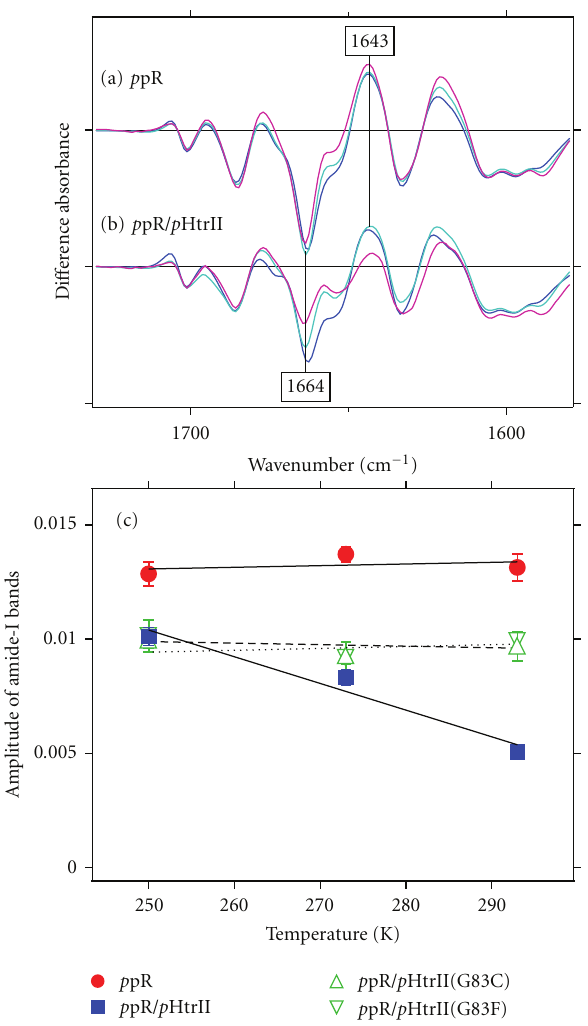
Figure 7: (The upper panel) p pR minus p pR infrared di ff erence M spectra without (a) and with (b) p HtrII in the 1730–1520 cm − 1 region. Spectra are measured at 250K (blue lines), 273 K (light blue lines), and 293 K (red lines) upon hydration with H 2 O. One division of the y axis corresponds to 0.01 absorbance units. (The lower panel) Temperature dependence of the amplitude of amide- I vibrations of helices (c). Di ff erence absorbances between 1643 and 1664 cm − 1 are plotted versus temperatures. The original data appeared in